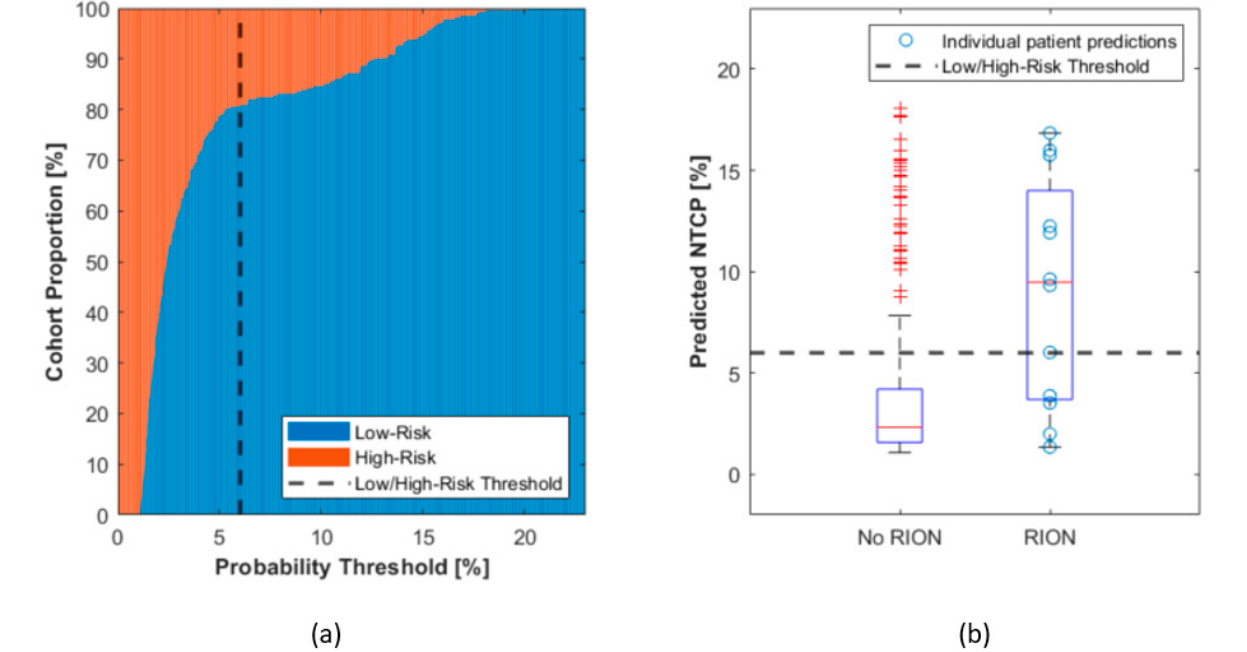
Figure 4. Threshold selection to segment patients into high- and low-risk groups. ( a ) The proportion of patients in each group is plotted for different thresholds. A threshold of 6% is proposed for patient classification into risk groups. ( b ) Boxplots for the predicted NTCPs for all patients in our cohort, and cases with and without RION reporting are analyzed individually. The selected threshold of 6% would permit high specificity (83%) and good sensitivity (67%) in our data.